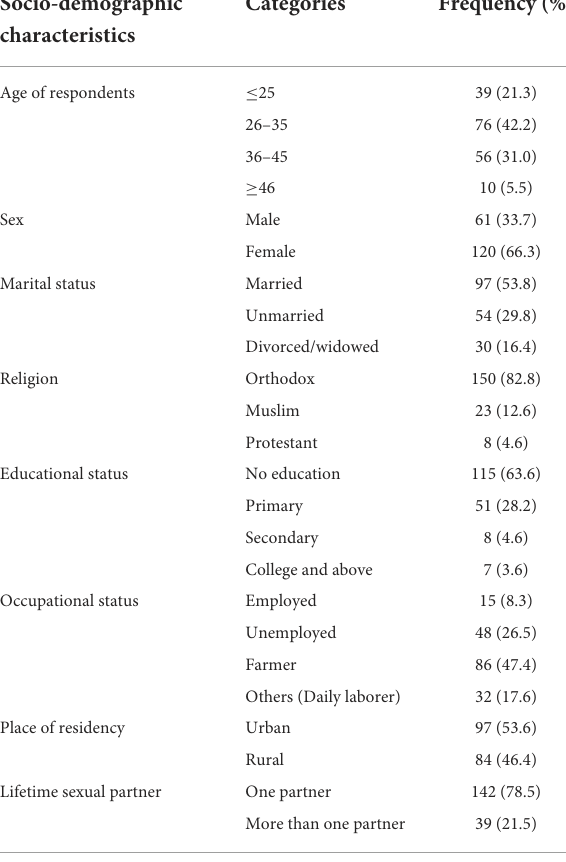
TABLE 1 Sociodemographic characteristics of respondents in Andabet district, Ethiopia, 2022.